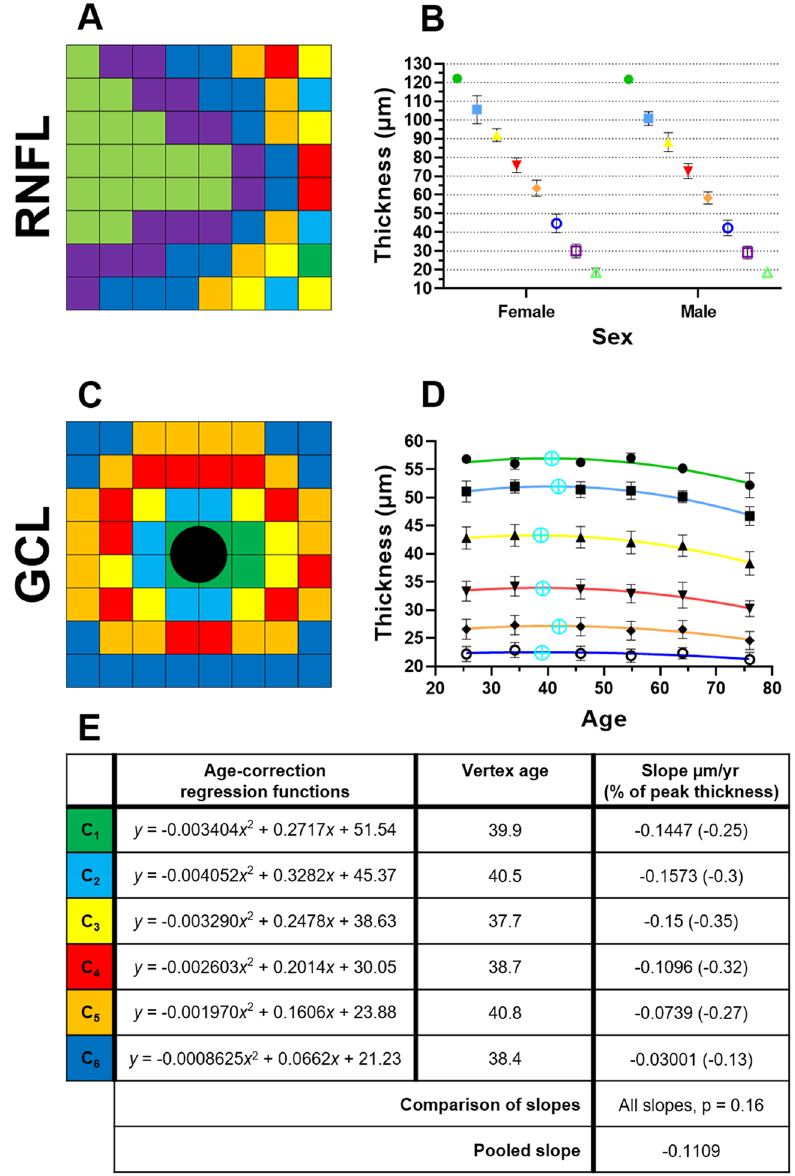
Figure 2. Spatial topography and age-related regression analysis where relevant in the ( A , B ) retinal nerve fibre layer (RNFL) and ( C–E ) ganglion cell layer (GCL), using location-specific cluster analysis. For each layer, the ( A,C ) spatial cluster patterns (in right eye format), ( B , D ) corresponding plots of cluster thickness versus groups, i.e. sex or age interval cohorts (cyan crosses denote vertex age), and ( E ) corresponding age-correction regression functions, vertex ages (if within the limits of this study’s cohort), and slopes as derived after the vertex age are presented. All slopes were significantly different from zero ( p < 0.05). Central black circle in the GCL represents the excluded central four grids containing the fovea. Regression characteristics are in the forms y = a x 2 + b x + c (quadratic) or y = m x + c (linear), where x = age, y = thickness (µm). ‘a’, ‘b’, and ‘m’ are co-efficients, and ‘c’ is a constant. Peak thicknesses were based off the vertex age for quadratic models, or y -intercept for linear models or cases where the vertex age was beyond the age limits of this study. In cases where post-vertex age included less than three averaged data points, the nearest neighbouring data points up to three averaged totals were included to minimise variability. Mean thickness ± SD of all plotted values are provided in (Supplementary Table